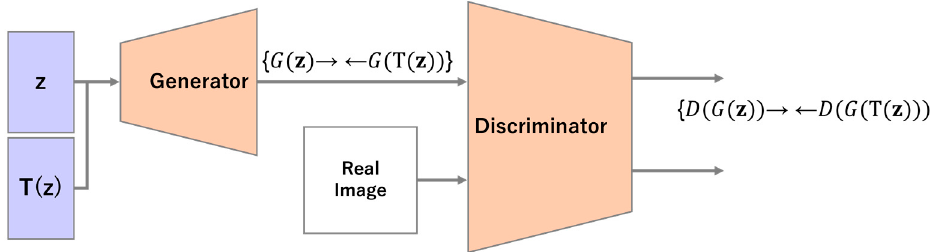
Figure 4. Overview of latent consistency regularization.